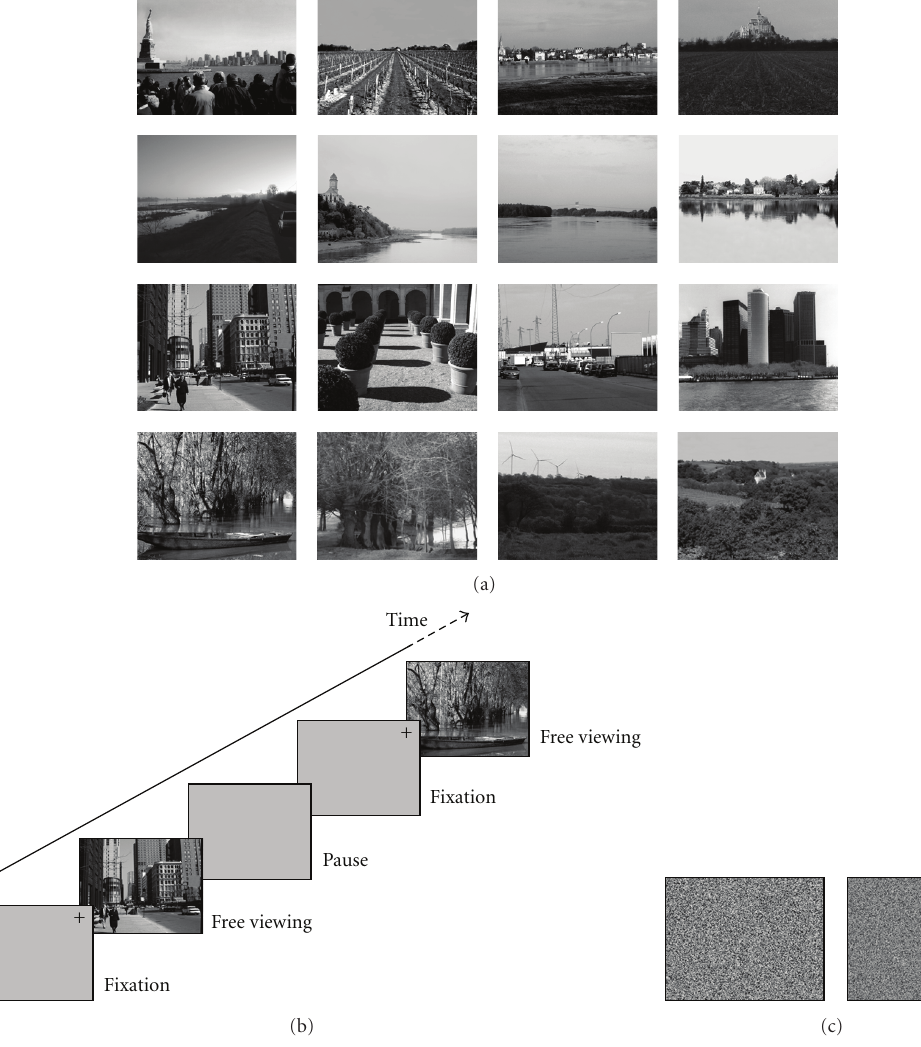
Figure 1: (a) Black-and-white photographs of natural scenes used as stimuli. (b) Time course of a trial in Exp. 1: after a 3-s fixation period, the stimulus appeared for free-time visual exploration before participants closed stimulus exposure by a click, then after a pause the next trial started. In Exp. 2, stimulus exposure was always 9s and there was no pause between trials. (c) Scrambled version of scenes in Exp.